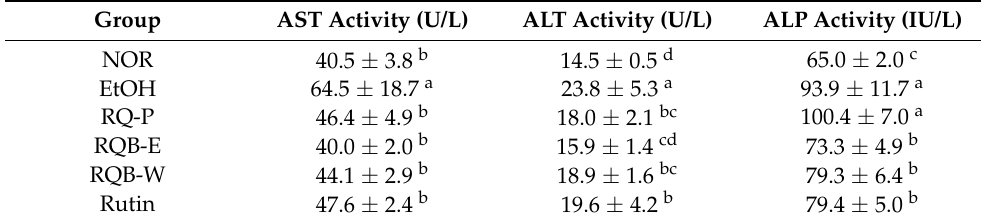
Table 3. Serum AST, ALT, and ALP activities of the AFLD